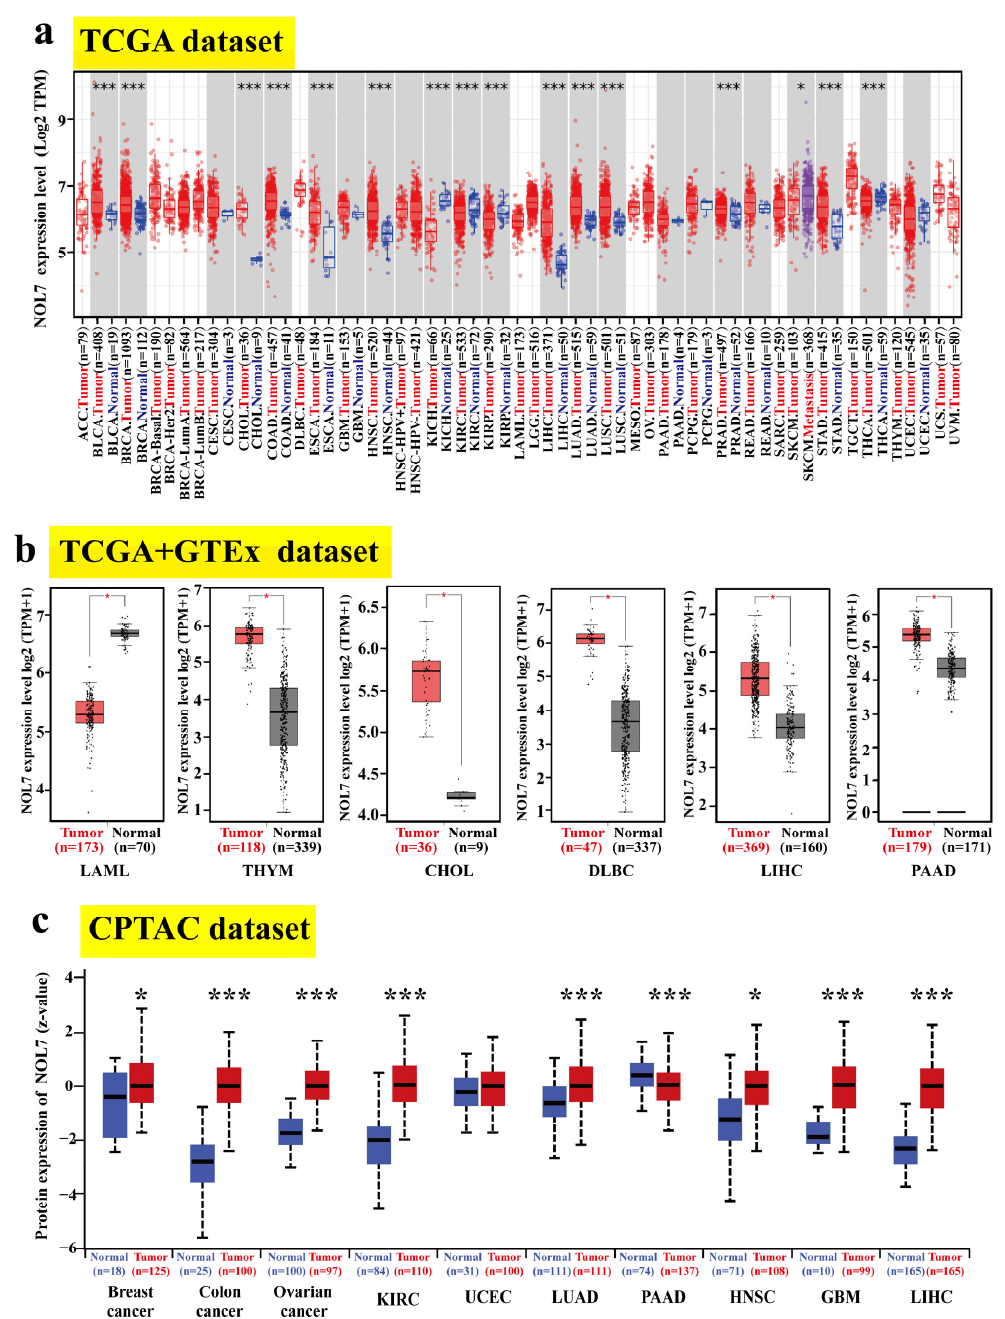
adenocarcinoma (PAAD) tissues as compared with corresponding normal tissues, while they were markedly lower in acute myeloid leukemia (LAML) tissues as compared with normal tissues (all p -values < 0.05).